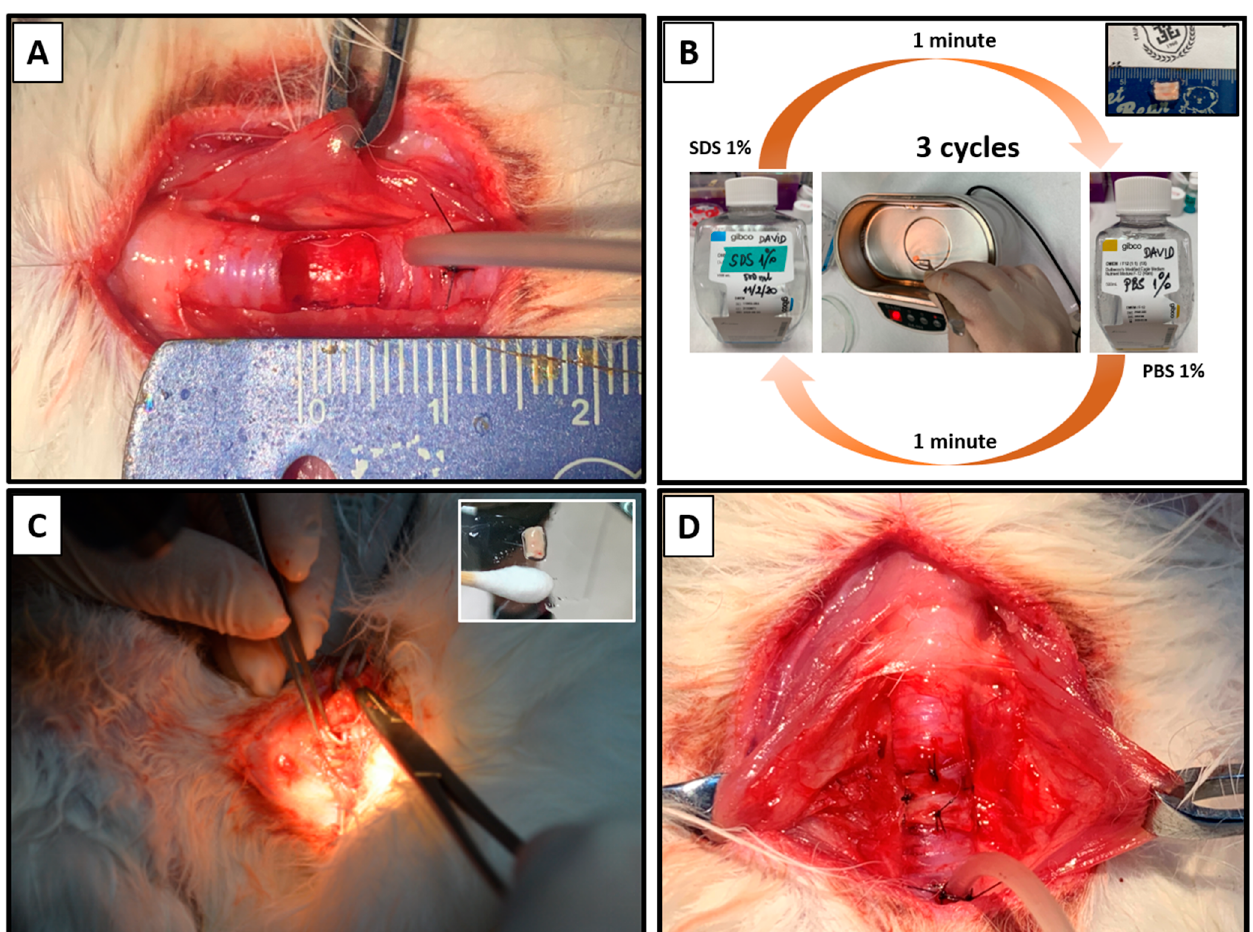
Figure 5. Autograft tracheal patch transplantation process. ( A ): Created defect with a semicylindrical shape measuring approximately 0.7 cm × 0.7 cm on the anterior aspect of the trachea ( B ): The excised part (small photo) underwent the partial decellularization process. ( C , D ): The partial decellularized autografts with the cell sheet applied in the luminal surface (small photo) were retransplanted into the original site.